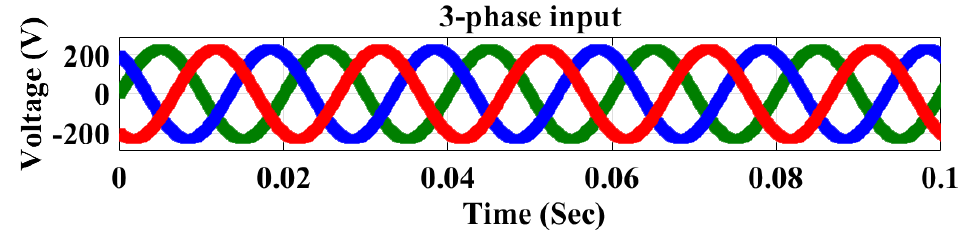
Figure 9. Three phase input voltage for SSTPI